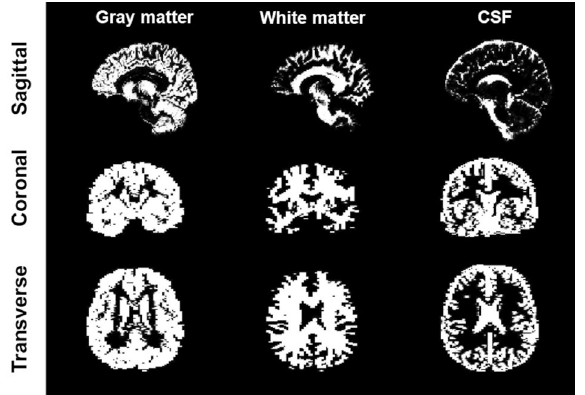
Figure 3. Tissues segmentation calculated from SPM. Each row shows slices of the 3D segmentation along a different direction. The resolutions are 1.5 × 1.5 mm 2 for sagittal, 3 × 1.5 mm 2 for coronal, and 1.5 × 3 mm 2 for transverse directions.